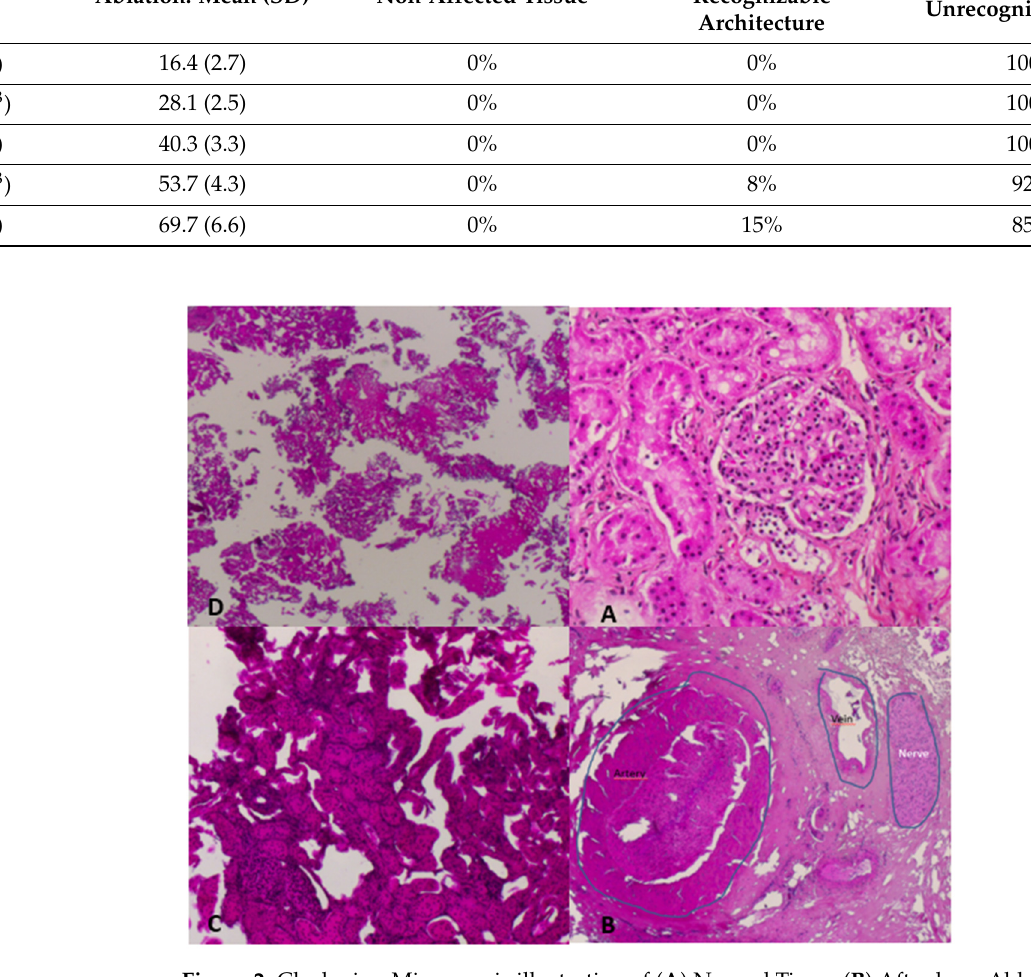
Figure 2. Clockwise: Microscopic illustration of ( A ) Normal Tissue ( B ) After laser Ablation showing necrotic tissue with recognized architecture ( C ) Ablated tissue and ( D ) Fragmented tissue.